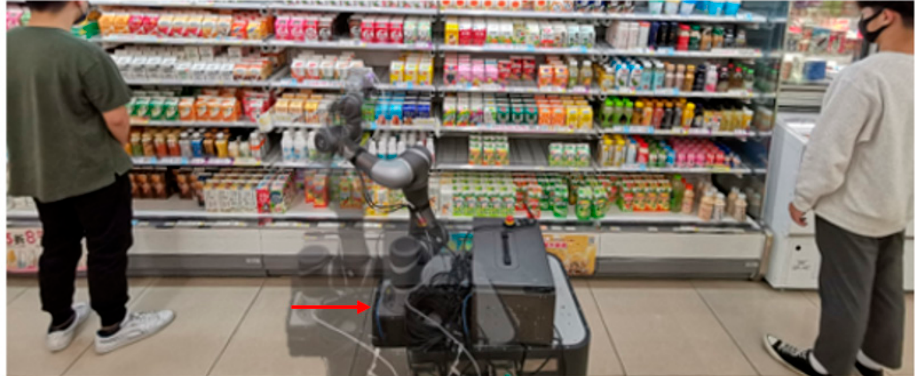
Figure 17. The robot conducted the replenishment task between two customers.